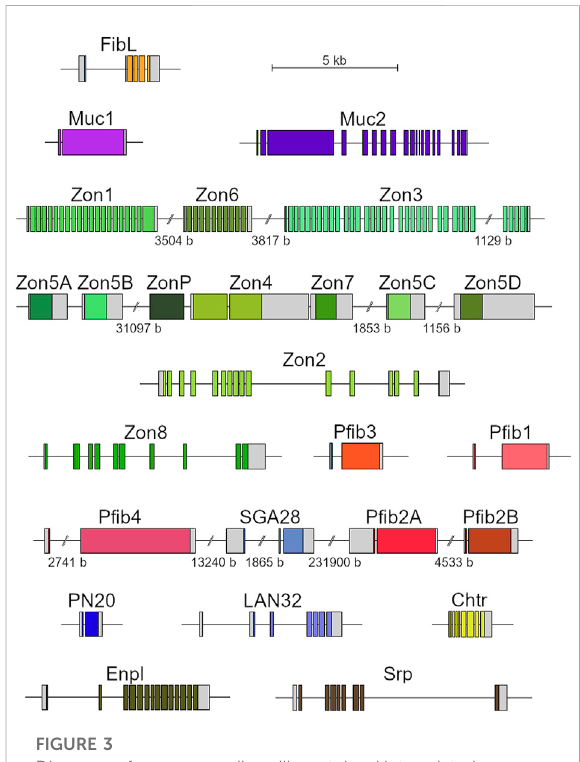
FIGURE 3 Diagrams of genes encoding silk proteins. Untranslated regions (UTRs) in grey; coding sequences in color (similar hues represent genes encoding proteins of a similar category); genes localized at the same genomic scaffold depicted in clusters; scale breaks in the intergenic regions labelled with the region lengths.